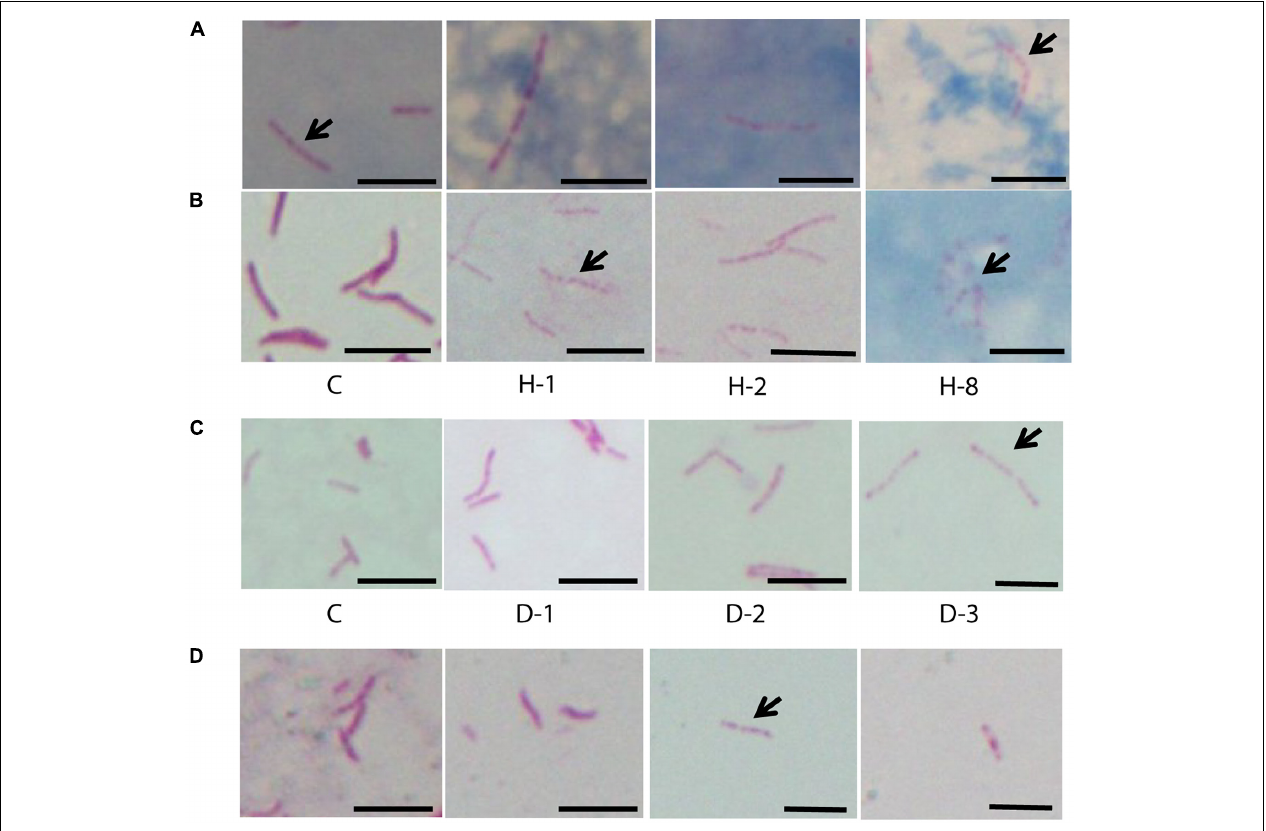
FIGURE 3 | Acid fast staining of M. tuberculosis cells in sputum, oxidative stress, iron deficiency, and isoniazid treatment. (A) Four sputum samples with M. tuberculosis cells ( n ∼ 100 cells). (B) Clinical M. tuberculosis strain treated with different concentrations of H 2 O 2 for oxidative stress and (C) DFO for iron deficiency ( n = 300 cells). (D) Clinical M. tuberculosis strains grown in the presence of isoniazid (0.015 µ g/ml) ( n ∼ 100 cells). C, untreated control; H 2 O 2 concentrations used are 21 (H-1), 42 (H-2), and 168 mM (H-8) and the concentrations of DFO are 100 (D-1), 250 (D-2), and 500 µ M (D-3), arrow indicates beaded cells and scale bar = 5 µ